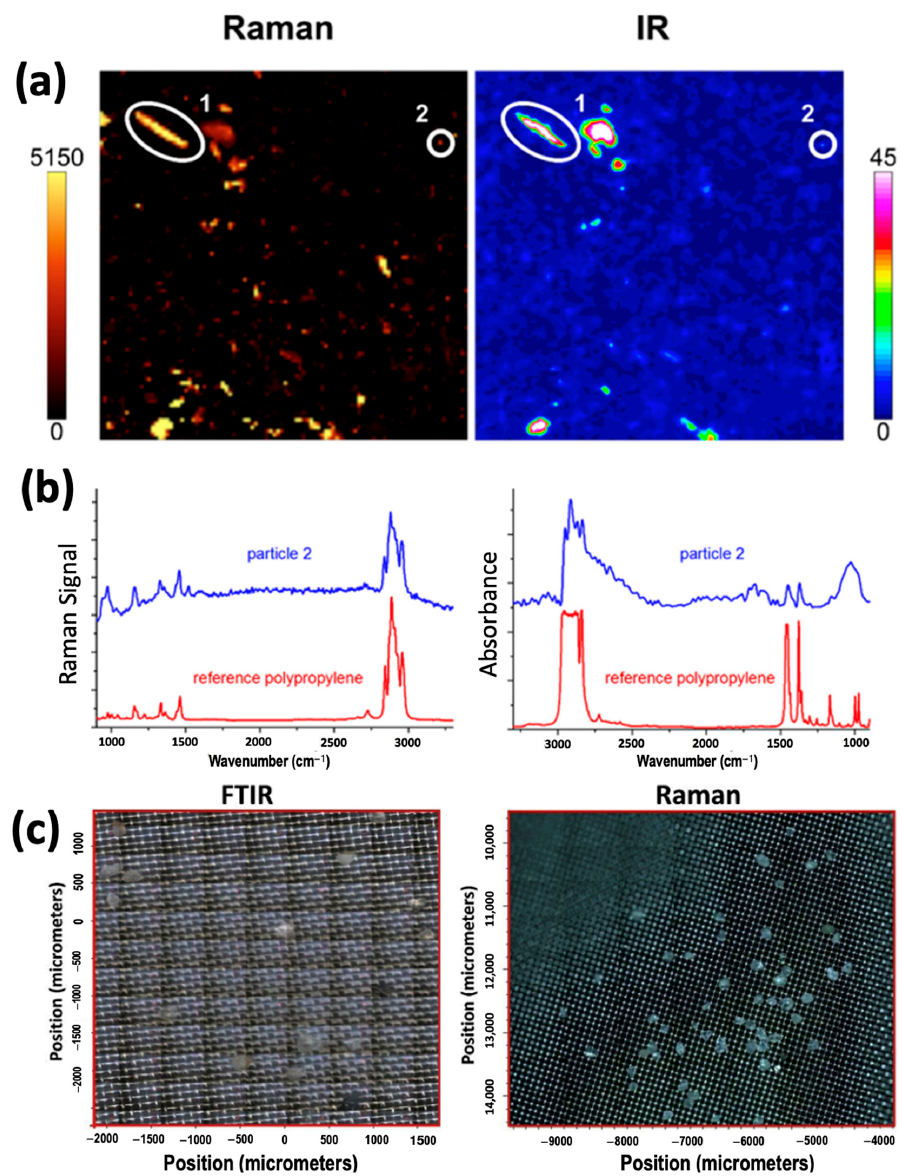
Figure 8. Direct comparisons between Raman and FTIR spectra/imaging of microplastics. ( a ) A Ra- man image ( left ) and an IR image ( right ) with false coloring denoting the spectral intensity in the 2780–2980 cm − 1 range. ( b ) A Raman spectrum ( left ) and an IR transmission spectrum ( right ) of particle 2 in comparison with a reference of polypropylene. ( c ) Images of unknown particles extracted from sediment and scanned via both FTIR and Raman microspectroscopy. ( a , b ) reproduced from Ref. [70] with permission from Springer Nature; ( c ) reproduced from Ref. [48] with permission of publisher.